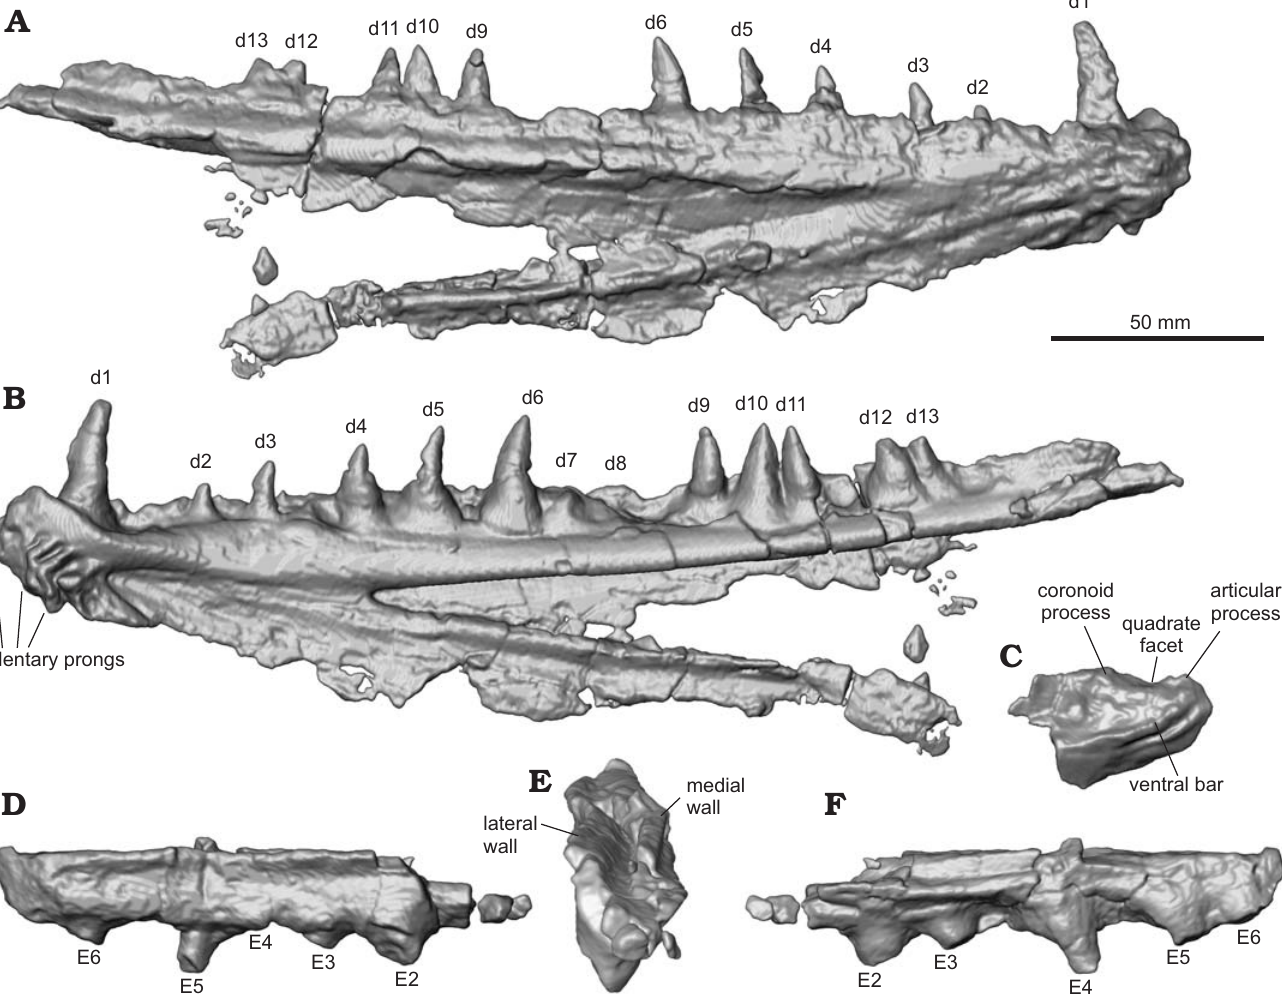
Fig. 3. Digital reconstructions of the aulopiform teleost Enchodus tineidae sp. nov. holotype (MUVP 59) from the Campanian of central Egypt. Right dentary showing its caudal extent, otherwise obscured by matrix, in lateral ( A ) and medial ( B ) views. Caudal portion of the left anguloarticular in lateral view ( C ), showing its dorsal aspect, otherwise obscured by matrix. Right ectopterygoid showing its caudal extent and dorsal aspect, otherwise obscured by matrix, in lateral ( D ), caudodorsal ( E ), showing V-shaped trough for articulation with the dermopalatine, and medial ( F ) views. Abbreviations: d, dentary tooth; E, ectopterygoid tooth; numbers 1–13 indicate tooth position in the respective